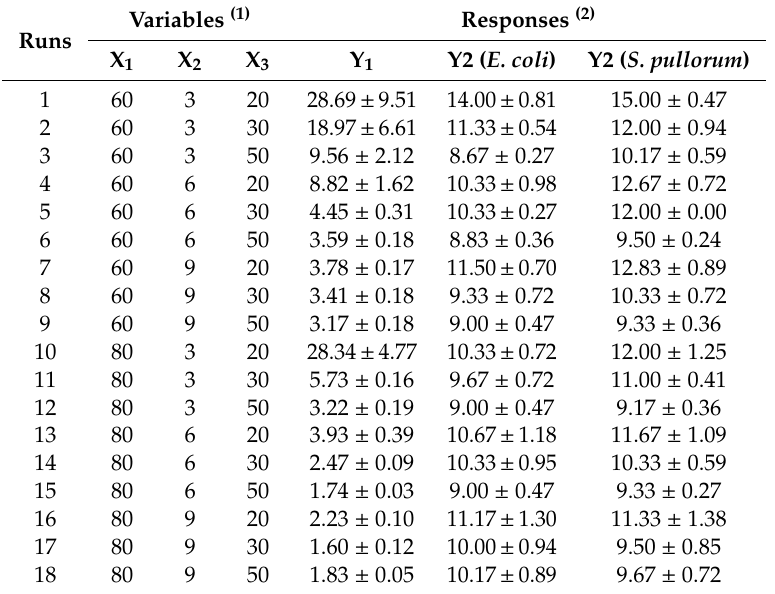
Table 4. Fractional factorial design (FFD) for evaluation of the e ff ect of critical factors (drying temperature, time, and the solid content (SBM) on antibacterial activities and moisture contents of the CC